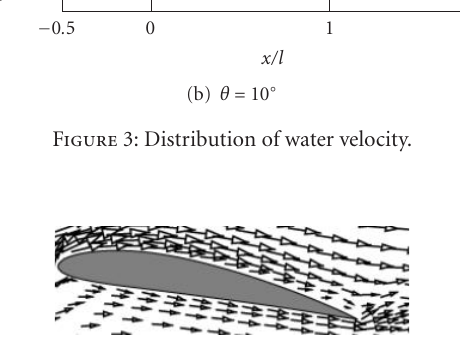
Figure 4: Closeup of velocity field near the separated region.